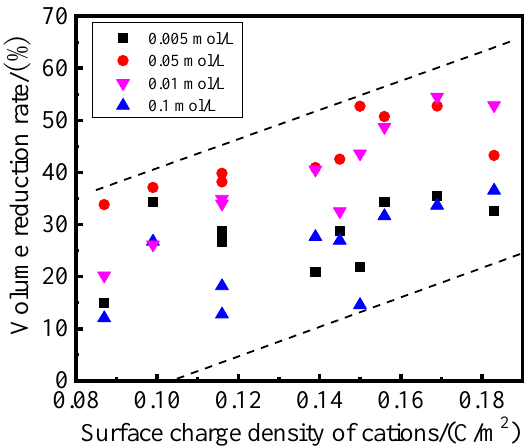
Figure 4. Relationship between surface charge density of cations and volume reduction rate of